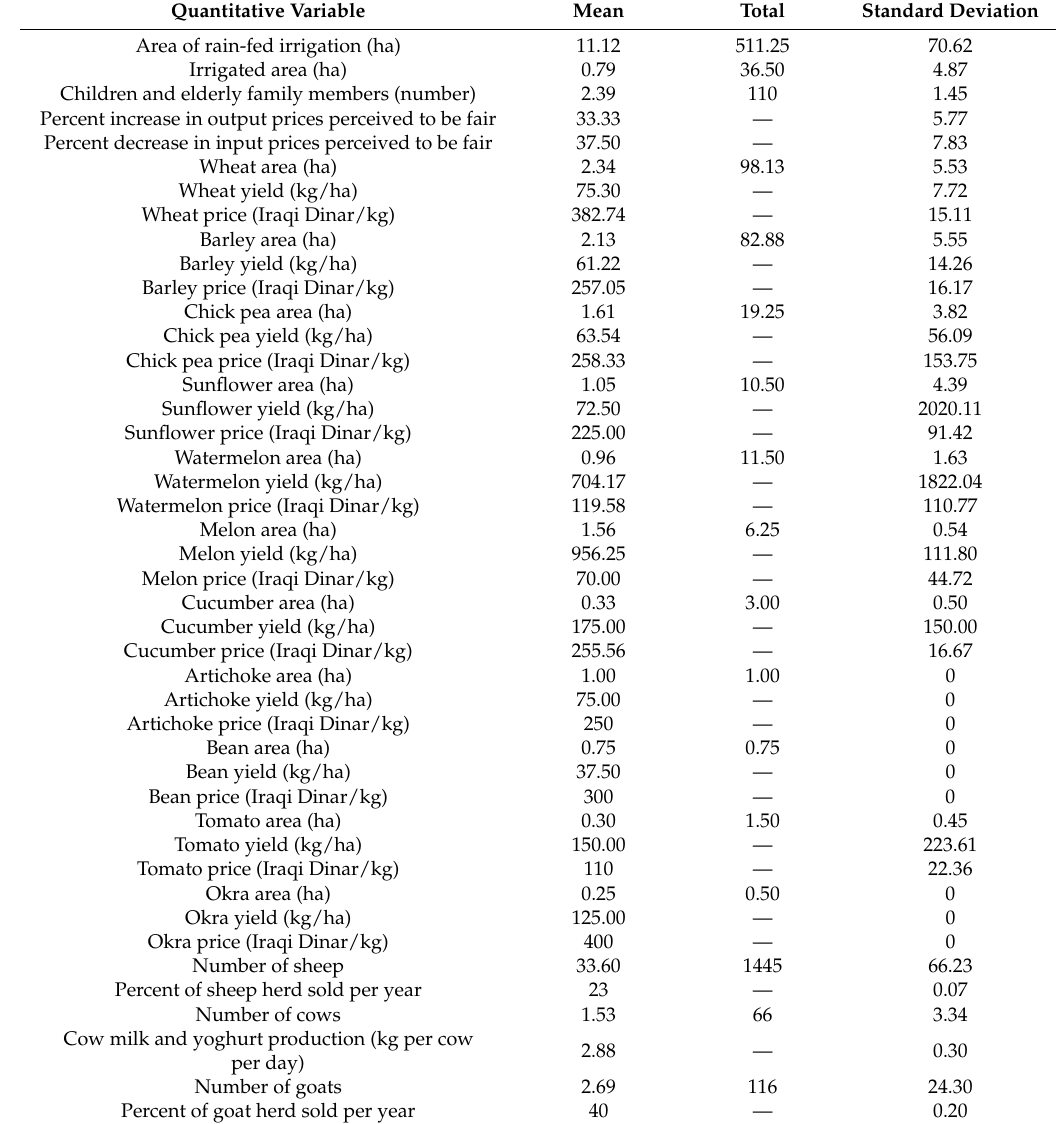
Table A1. Additional quantitative variables used to describe the survey population (1 USD = 1250 Iraqi